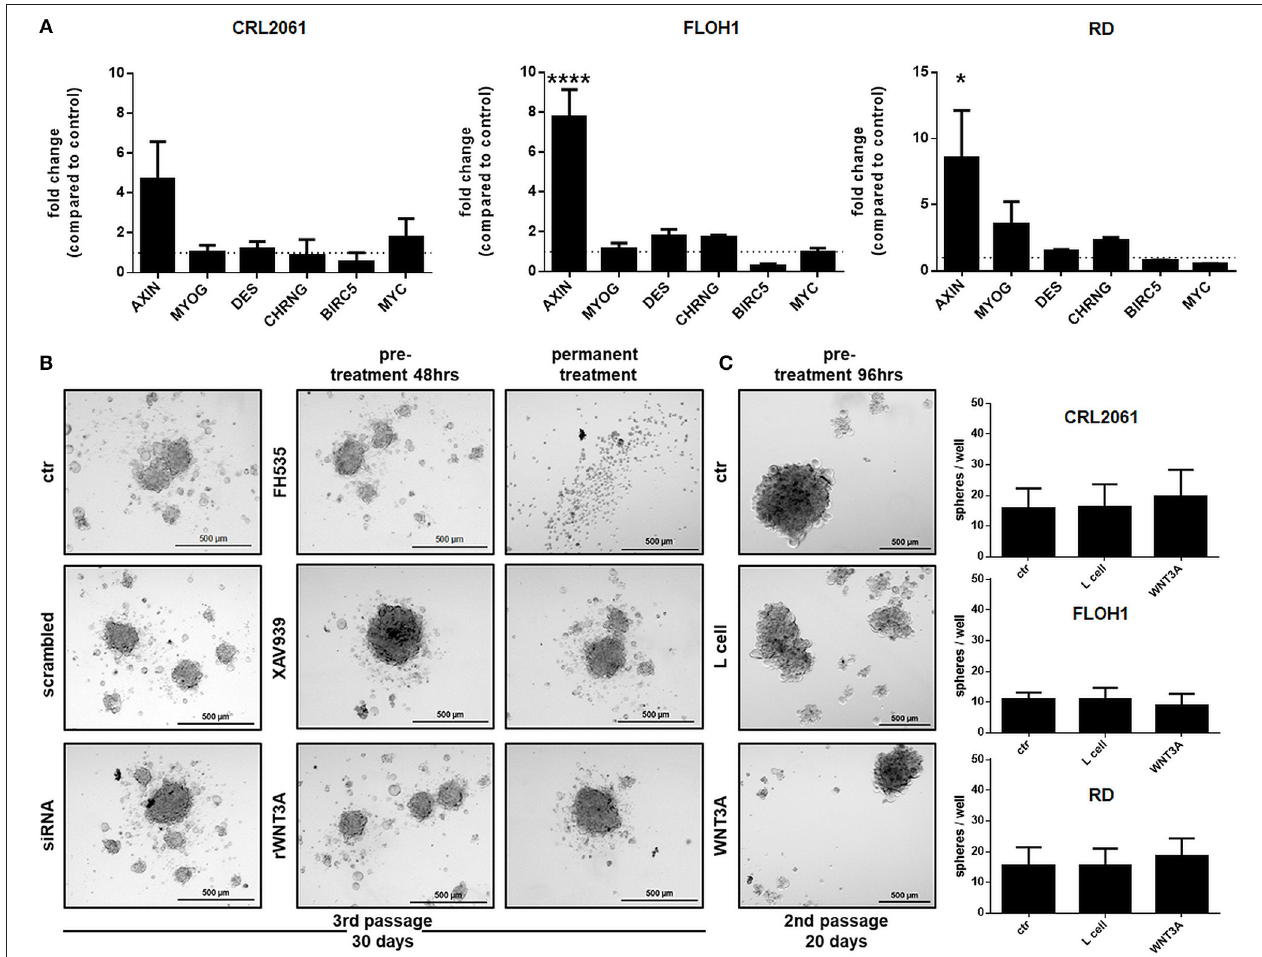
FIGURE 8 | Effects of FH535, XAV939, ß-catenin-siRNA, or WNT3A on the expression of muscle differentiation markers and ß-catenin target genes, and on sphere formation ability. (A) qRT-PCR of muscle differentiation and ß-catenin target genes after treatment with WNT3A for 96h. GAPDH expression was used for normalization. Shown is the mean and SEM of three independent experiments measured in duplicates. MYOG, myogenin; DES, desmin; CHRNG, acetylcholine receptor gamma subunit. (B) Pictures of sphere formation after pre-treatment with FH535 (20 µ M), XAV939, ß-catenin-siRNA, or rWNT3A and with or without permanent FH535 (5 µ M), XAV939 or rWNT3A treatment after 30 days or (C) pictures of sphere formation after a long term pre-treatment (96h) with WNT3A. Right panel shows quantification of spheres after long term treatment with WNT3A. Shown are the mean values of three independent experiments performed in duplicates. Pictures were taken with a 50-fold magnification. Significance level: * p < 0.05, **** p < 0.0001.